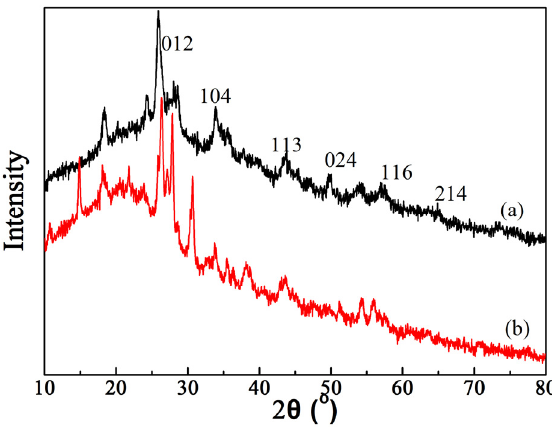
Figure 11. XRD spectra of α‐ Fe 2 O 3 @PHCMs before ( a ) and ( b ) after three repeated treatments.